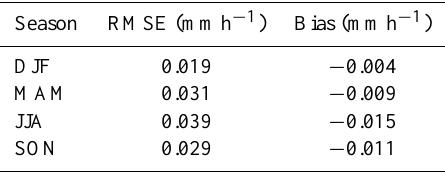
Table 6. RMSE and bias between (i) the hourly ET 0 obtained with the disaggregation method starting from T min and T max , and (ii) the hourly ET 0 estimated with the PM formula using the meteorological data for each season of the years